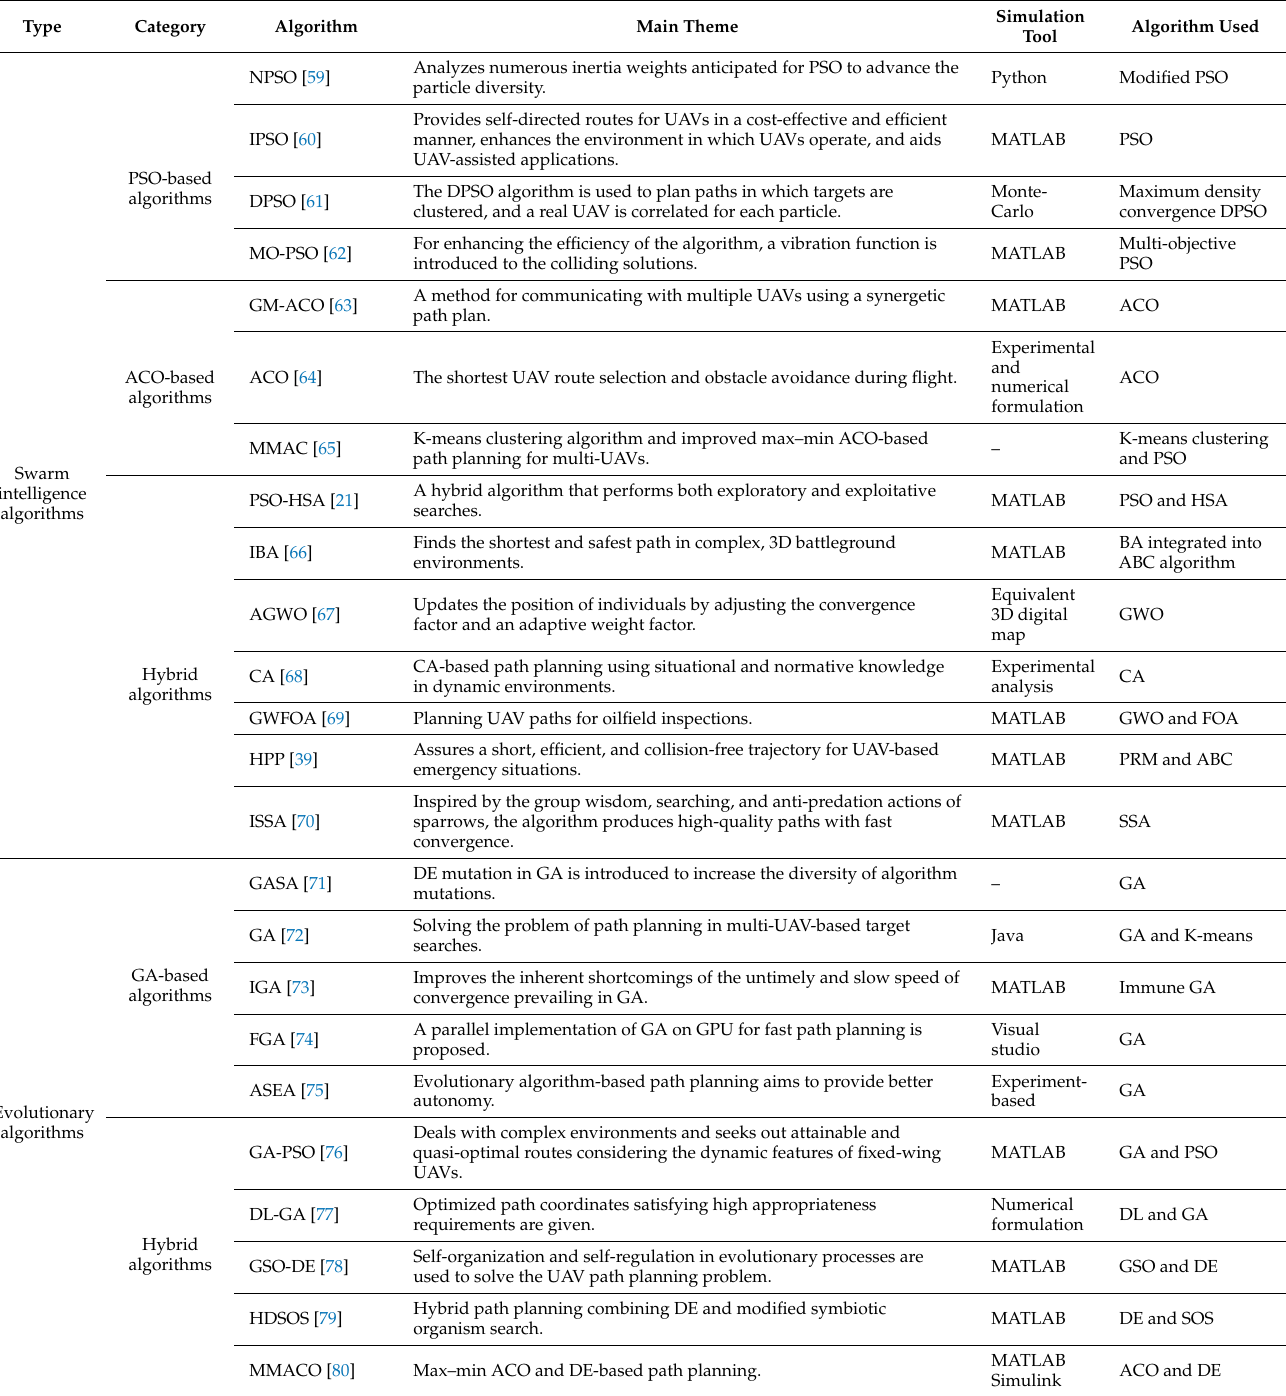
Table 3. Comparison of the bio-inspired algorithms in terms of main theme, tool, and design